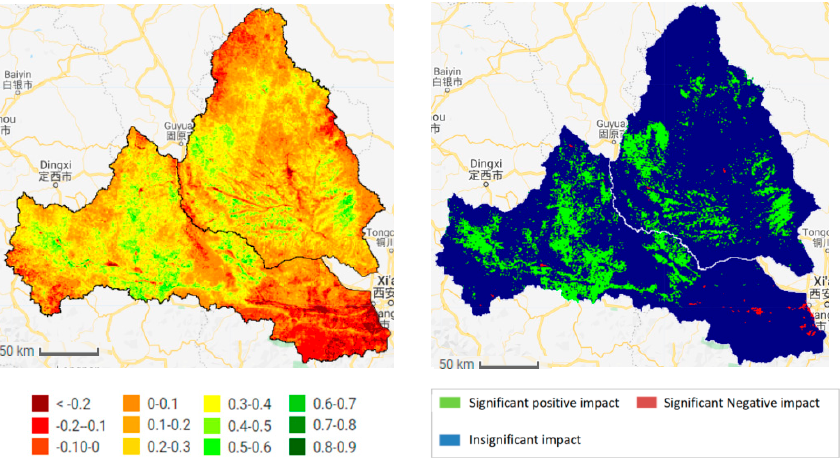
Figure 11. The spatial distribution of NDVI residuals in Wei and Jing River basins during 1987–2018 ( Left : Trend, Right : Significant change).